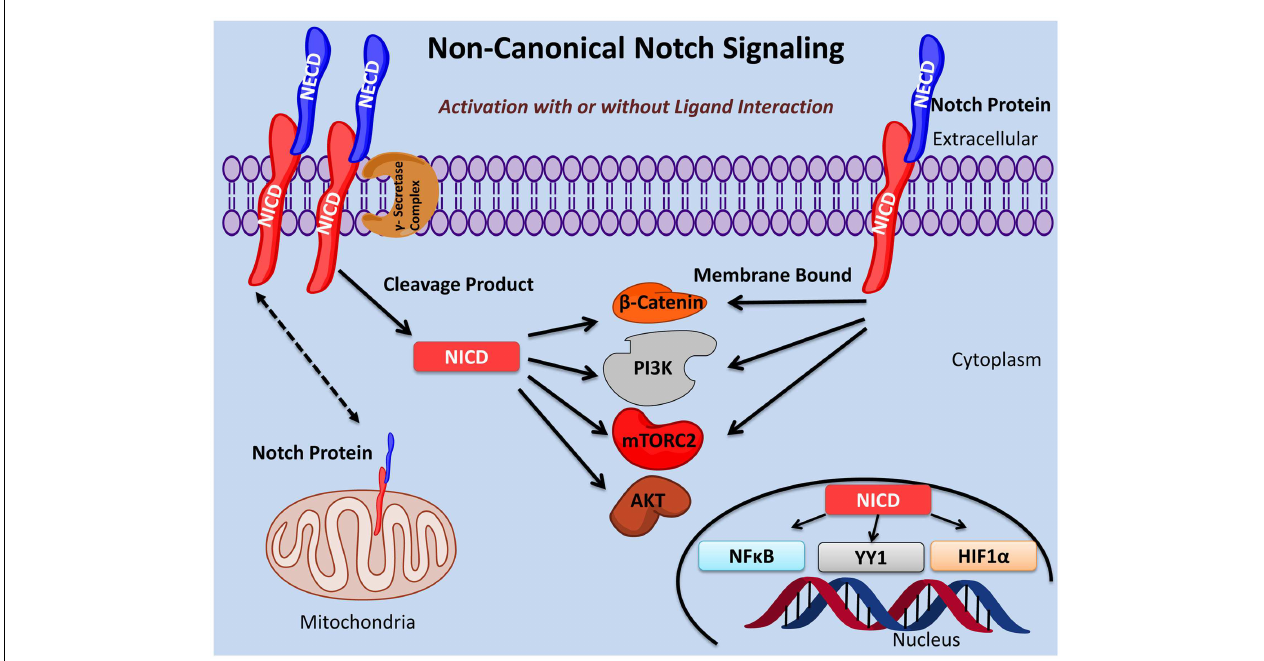
interacts with PI3K, mTORC2, AKT,Wnt, NF κ B,YY1, or HIF-1 α pathways at either the cytoplasmic and/or nuclear levels. Non-canonical Notch signaling regulates cell survival, metabolism, and differentiation through interaction with these pathways in many important biological processes including immunity and